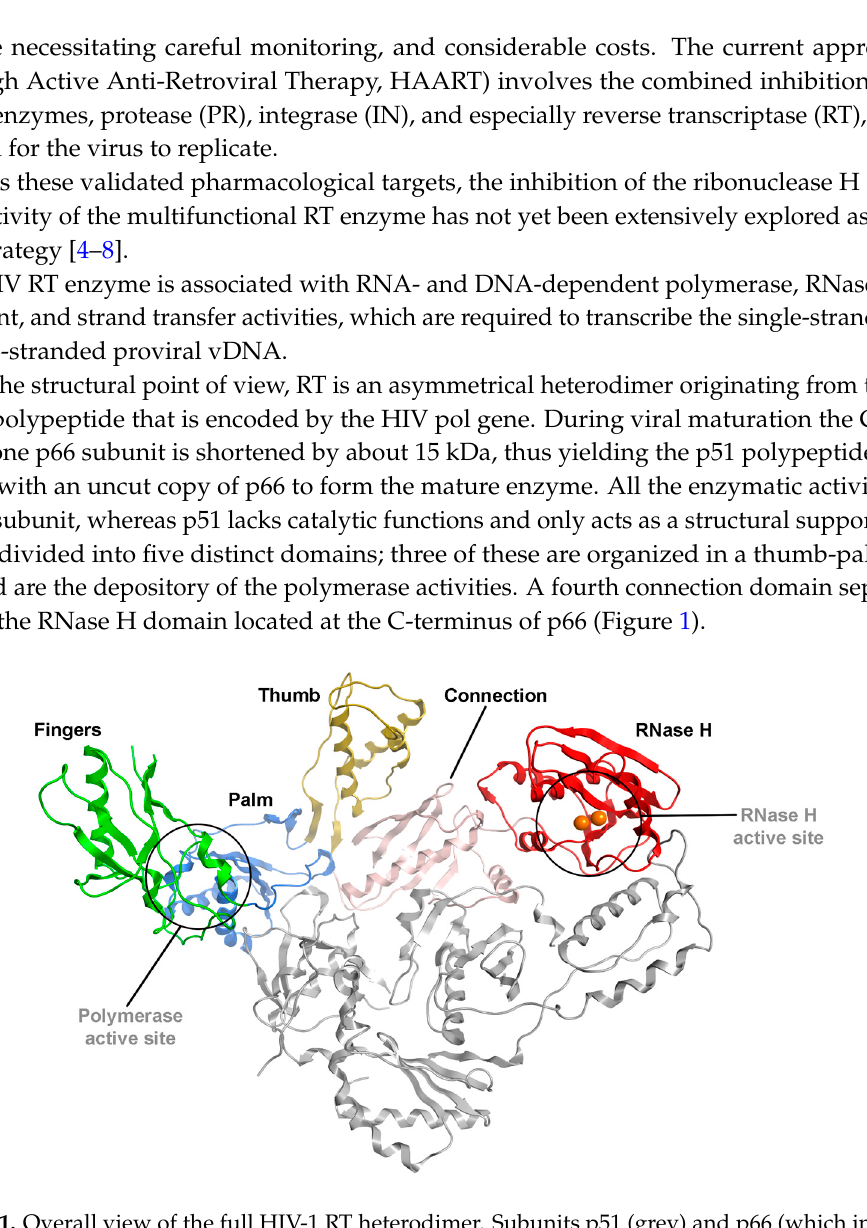
Figure 1. Overall view of the full HIV-1 RT heterodimer. Subunits p51 (grey) and p66 (which include fingers, palm, thumb, connection, and RNase H sites) are depicted as ribbon. Polymerase and RNase H active sites are circled in black. The RNase H metal cofactors are represented as orange spheres.